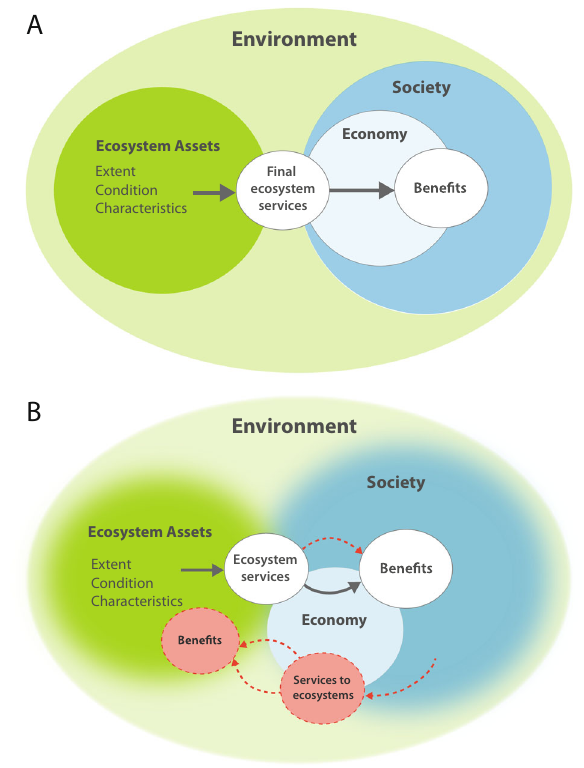
Fig. 1 Conceptual diagram of ecosystem accounting fl ows. In A the SEEA- EA conceptual diagram of ecosystem service fl ows (UN et al., 2021, p. 28) shows a one-way fl ow of bene fi ts from ecosystems to people via the economy. In B , an indicative example of how two-way fl ows may be included within this model is provided. Bene fi ts from ecosystem services are recognised as both fl owing through the economy and outside of it. Society contributes services to ecosystems (e.g., enhancing, restoring, protecting services (Comberti et al., 2015)), and these services may be provided via the economy (e.g., through labour), but also outside the formal economy. The blurred boundaries of the ‘ ecosystem ’ and ‘ society ’ entities depicted are representative of the continuity of relationships that underpin many Indigenous relationships between humans and